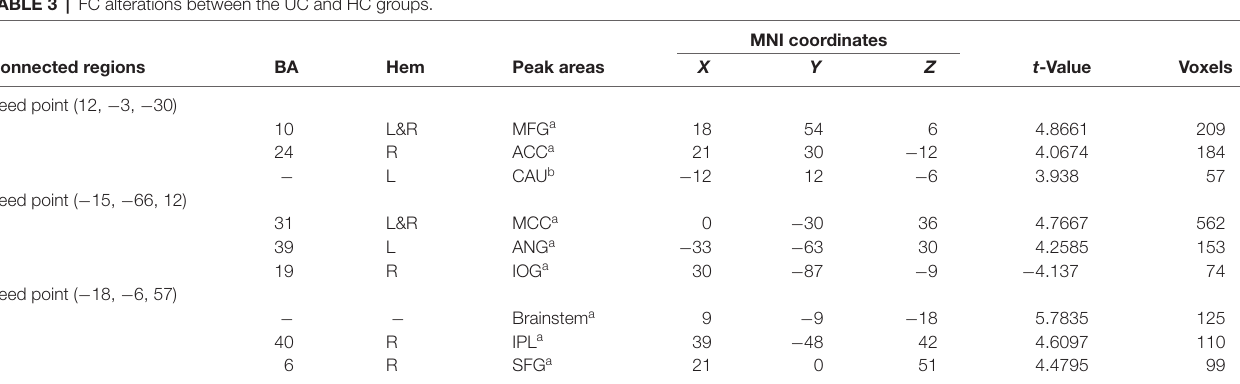
TABLE 3 | FC alterations between the UC and HC